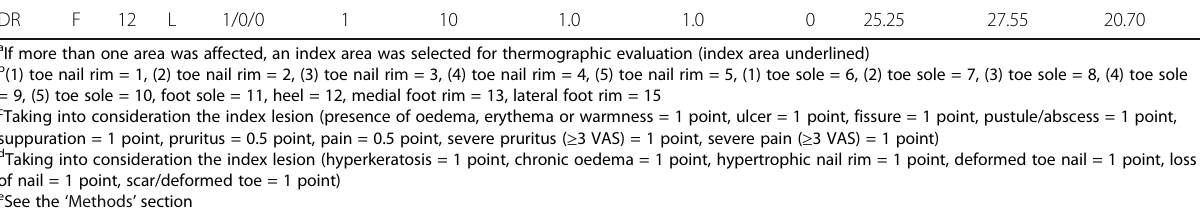
the foot is clearly visible [Fig. 3e]. In the iron transform- ation, distinct hypothermic areas at the lateral rim are visible [Fig. 3f]. They correspond to hyperkeratotic areas resulting from multiple previous infections.